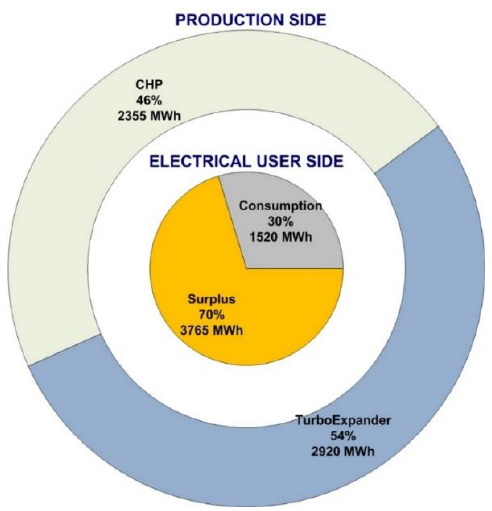
Figure 1. Yearly overview of the current electric production and demand in the Gavette district.